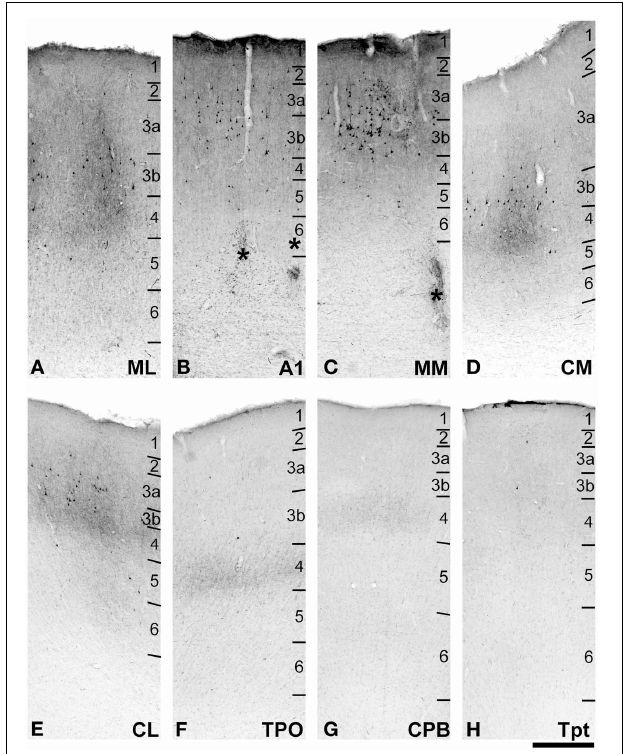
FIGURE 8 | BDA labeling by injection of CM in Case 3. Low magnification images of sections oriented from rostral (A) to caudal (H) along the STG. Black signal visible in each panel shows anterograde and retrograde transport from the BDA injection in the rostral and medial portions of CM (E,F) . Rectangular selections correspond to higher magnification images in Figure 9 . Open symbols in (A) indicate location of labeled cell somata in the insula. Asterisks in (C,D) denote locations of electrolytic lesions. Scale, 2mm.